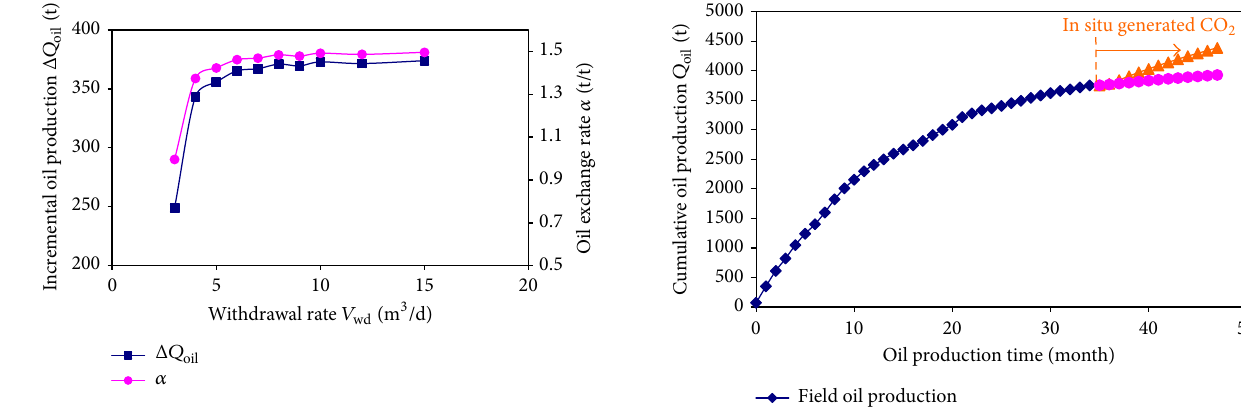
Figure 15: The incremental oil production and oil exchange rate at different oil withdrawal rates.